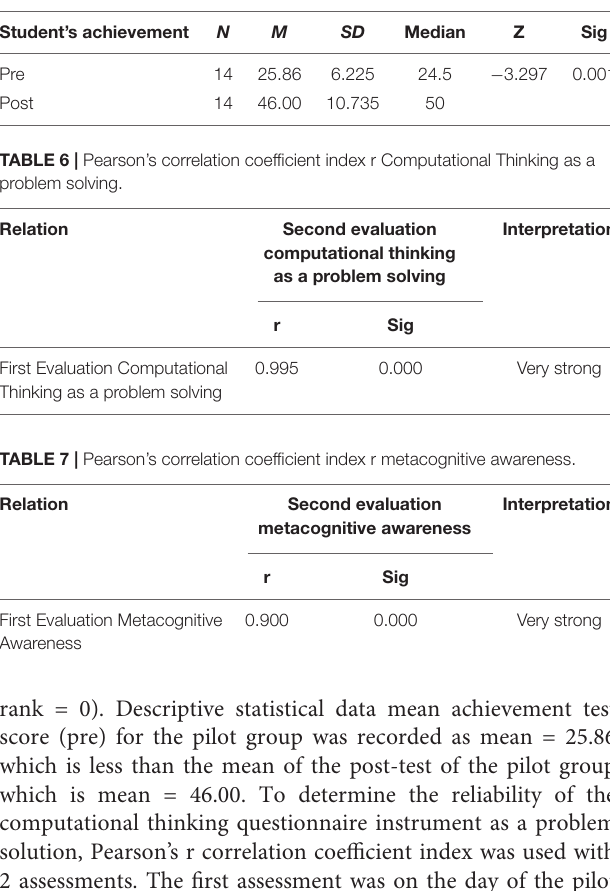
TABLE 5 | Wilcoxon Signed Rank exams for pre and post exams for achievement scores.